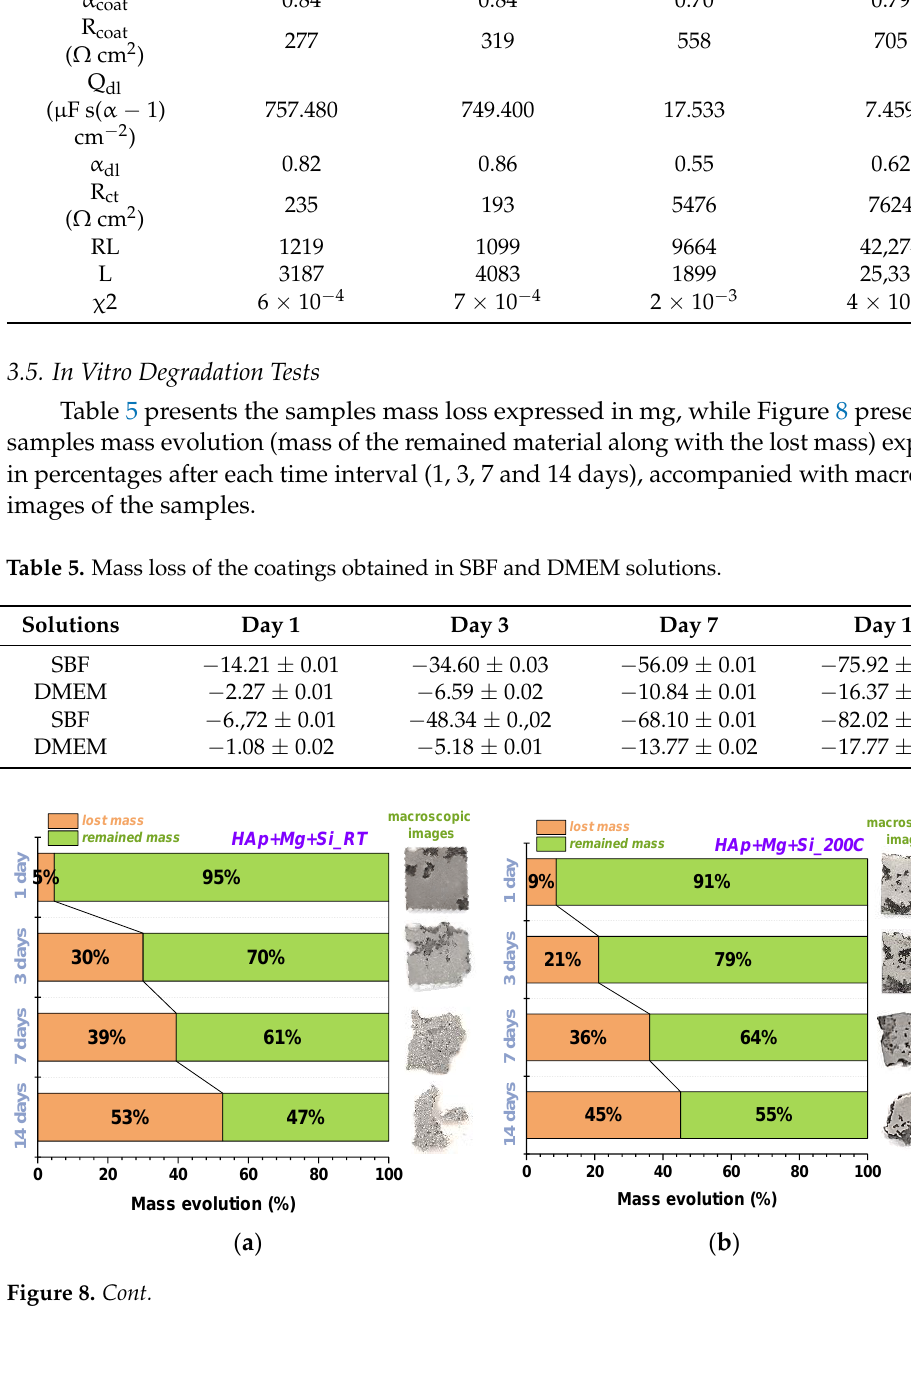
Table 4. EIS fitting results of the coatings obtained in SBF and DMEM solutions.